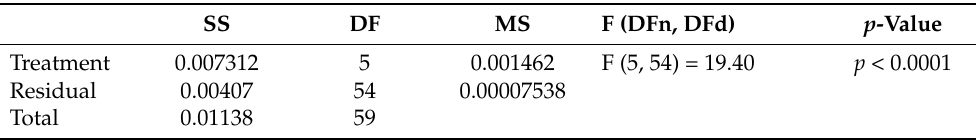
Table 13. ANOVA test of the results achieved by the proposed feature selection method when applied to the solar radiation